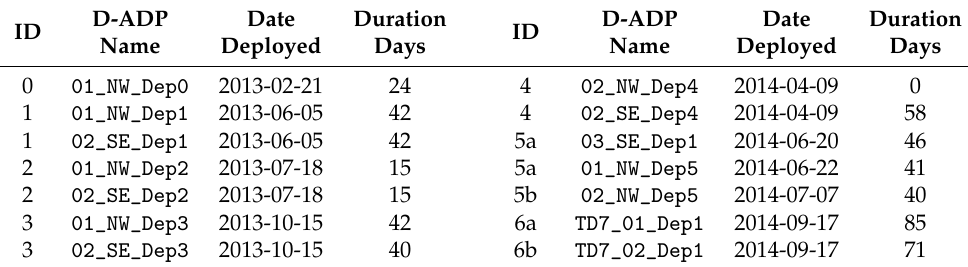
Table 1. Turbine-proximal deployments of D-ADPs showing unique campaign ID, date deployed and duration of deployment. Locations are shown in Figure 1c. Due to a memory card error, no data were retrieved from the Deployment (Dep) 4 “NW”.